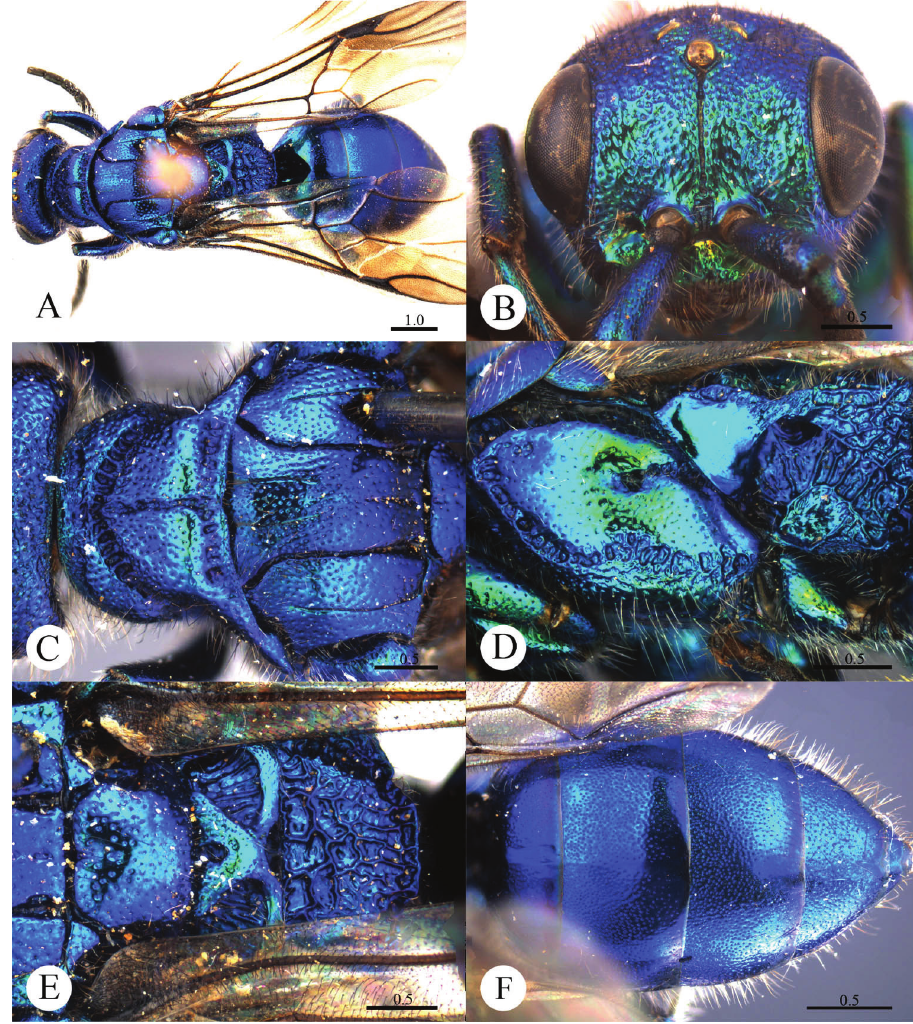
Plate 9. Cleptes seoulensis Tsuneki, 1959, male from Anhui. A Habitus dorsal B Head anterior C Prono- tum and mesoscutum dorsal D Mesopleuron and metapleuron lateral e Mesoscutellum, metanotum and propodeum dorsal F Metasoma dorsal. Scale bars in